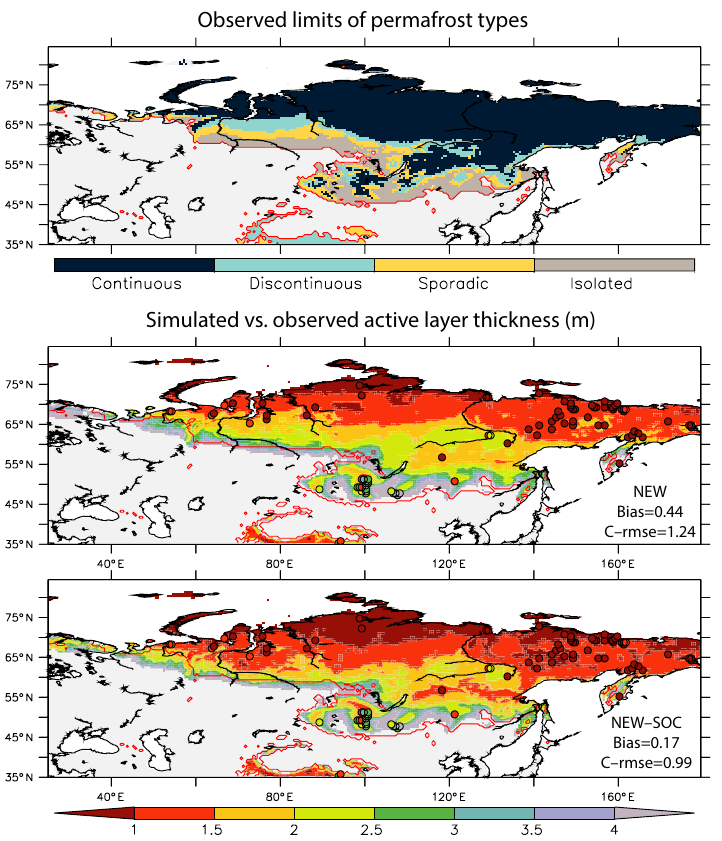
Figure 12. Distribution of permafrost characteristics. The NSIDC estimated limits of continuous, discontinuous, sporadic, and isolated permafrost regions are shown in the top panel. In each panel the red lines correspond to the observed boundary of the entire permafrost region. In the middle and the bottom panels, the mean active layer thicknesses simulated over the 1990–2013 period by the NEW and the NEW-SOC experiments are shown and compared to observations from the CALM network (circles). Total skill scores are given for each experiment.